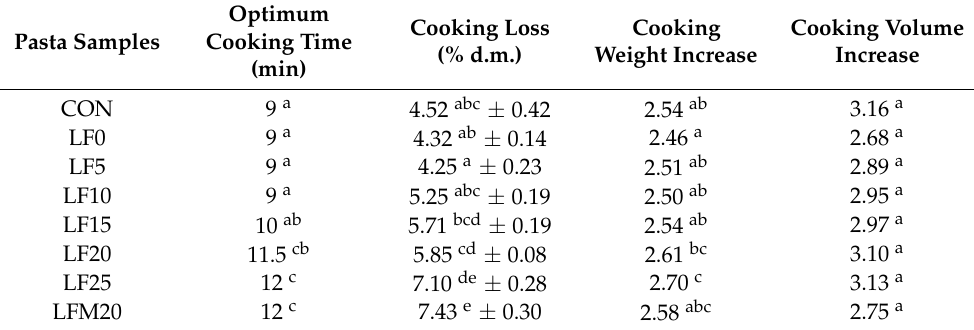
Table 4. Cooking quality of pasta samples.